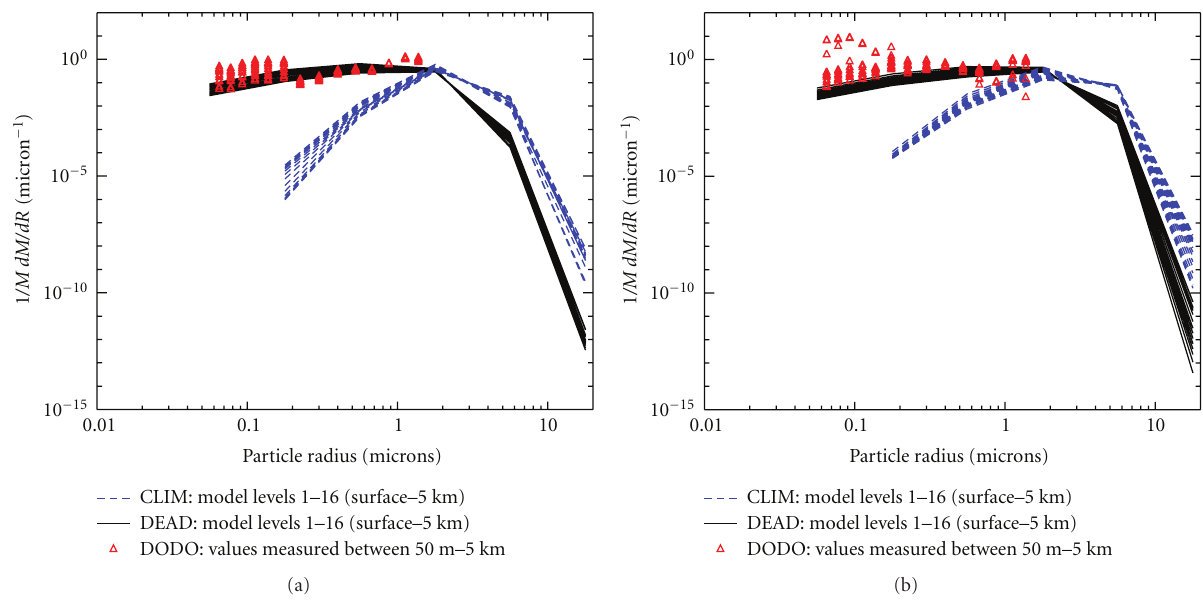
Figure 4: Normalised mass size distributions as a function of particle radius taken at 330 ◦ E and 17.5 ◦ N in CLIM (dashed blue lines) and DEAD (solid line) at each of the levels 1–16 (approximately from the surface to 5km) for (a) DJF and (b) JJA. Corresponding values of the normalised mass size distribution from the DODO campaigns, between the surface and 5km, (red triangles) are overlaid for (a) DJF and (b)